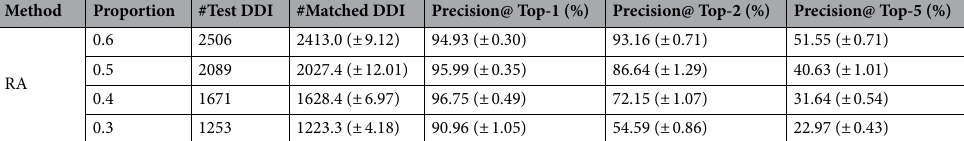
Table 4. Performance evaluation of ground truth using joint dataset and Neighborhood-based Similarity- based (RA)